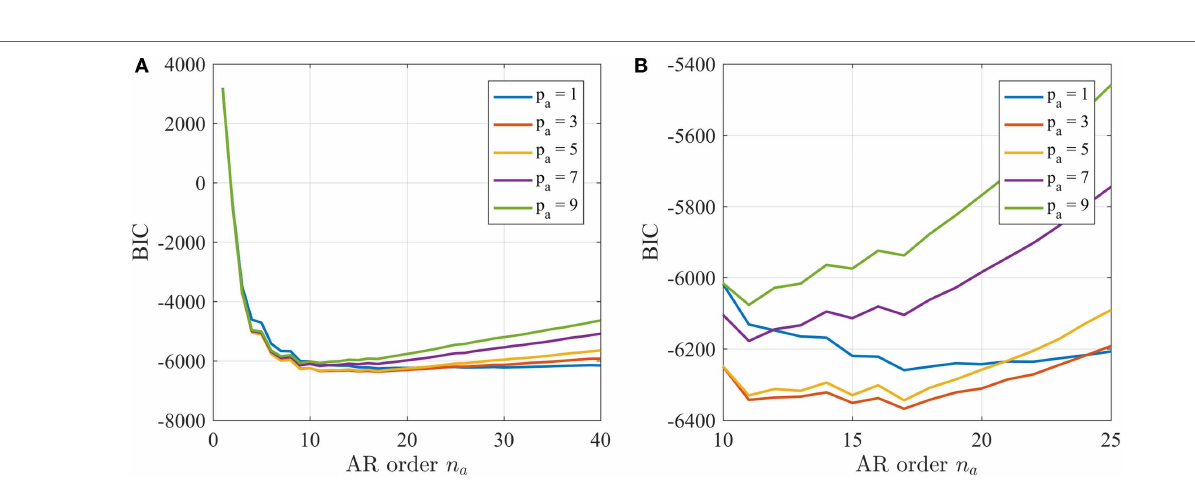
FIGURE 9 | Selection of the LPV-AR model structure: BIC curves for increasing model orders n a = 1, 2, ::: ,40 and for different basis orders p a = 1, 3, ::: ,9: (A) whole range; (B) detail in the range n a = [10, 25].